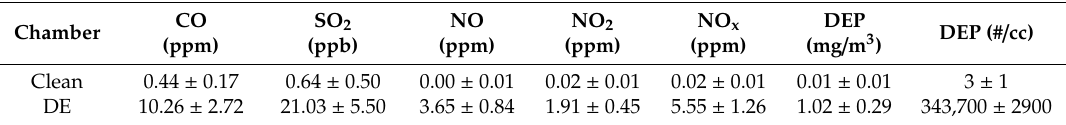
Table 1. The concentration of gases and particles in each